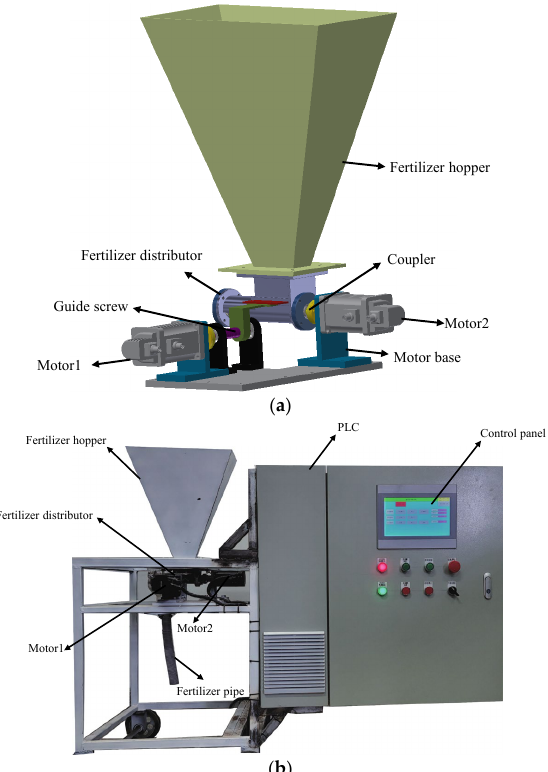
Figure 2. Overall structure of the fertilization platform: ( a ) structure of the test platform; ( b ) real image of the test platform.